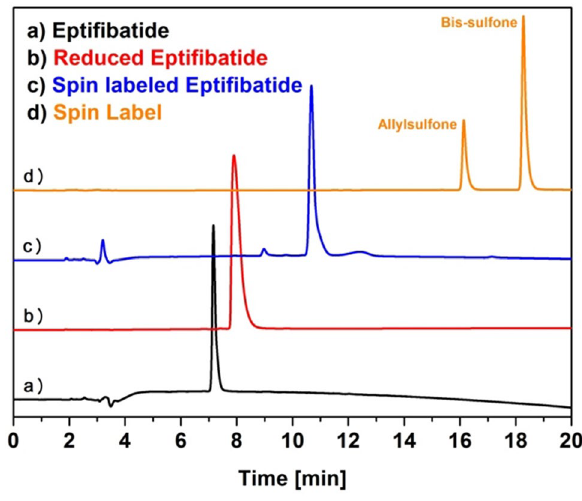
Figure 1. HPLC traces (214 nm, with gradient of acetonitril in water from 20 to 80% with 0.1% TFA for 20 min) illustrating the intercalation process. (a) eptifibatide 1 , (b) reduced eptifibatide 2 , (c) spin labeled eptifibatide 3, (d) mixture of the spin labels 4 and 5